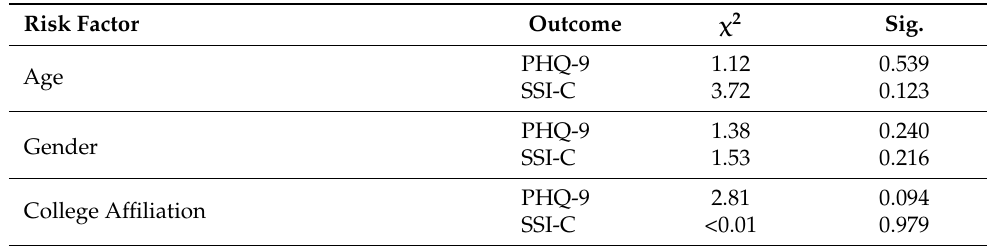
Table 1. Chi-squared tests for PHQ-9 and SSI-C risk factors. Risk